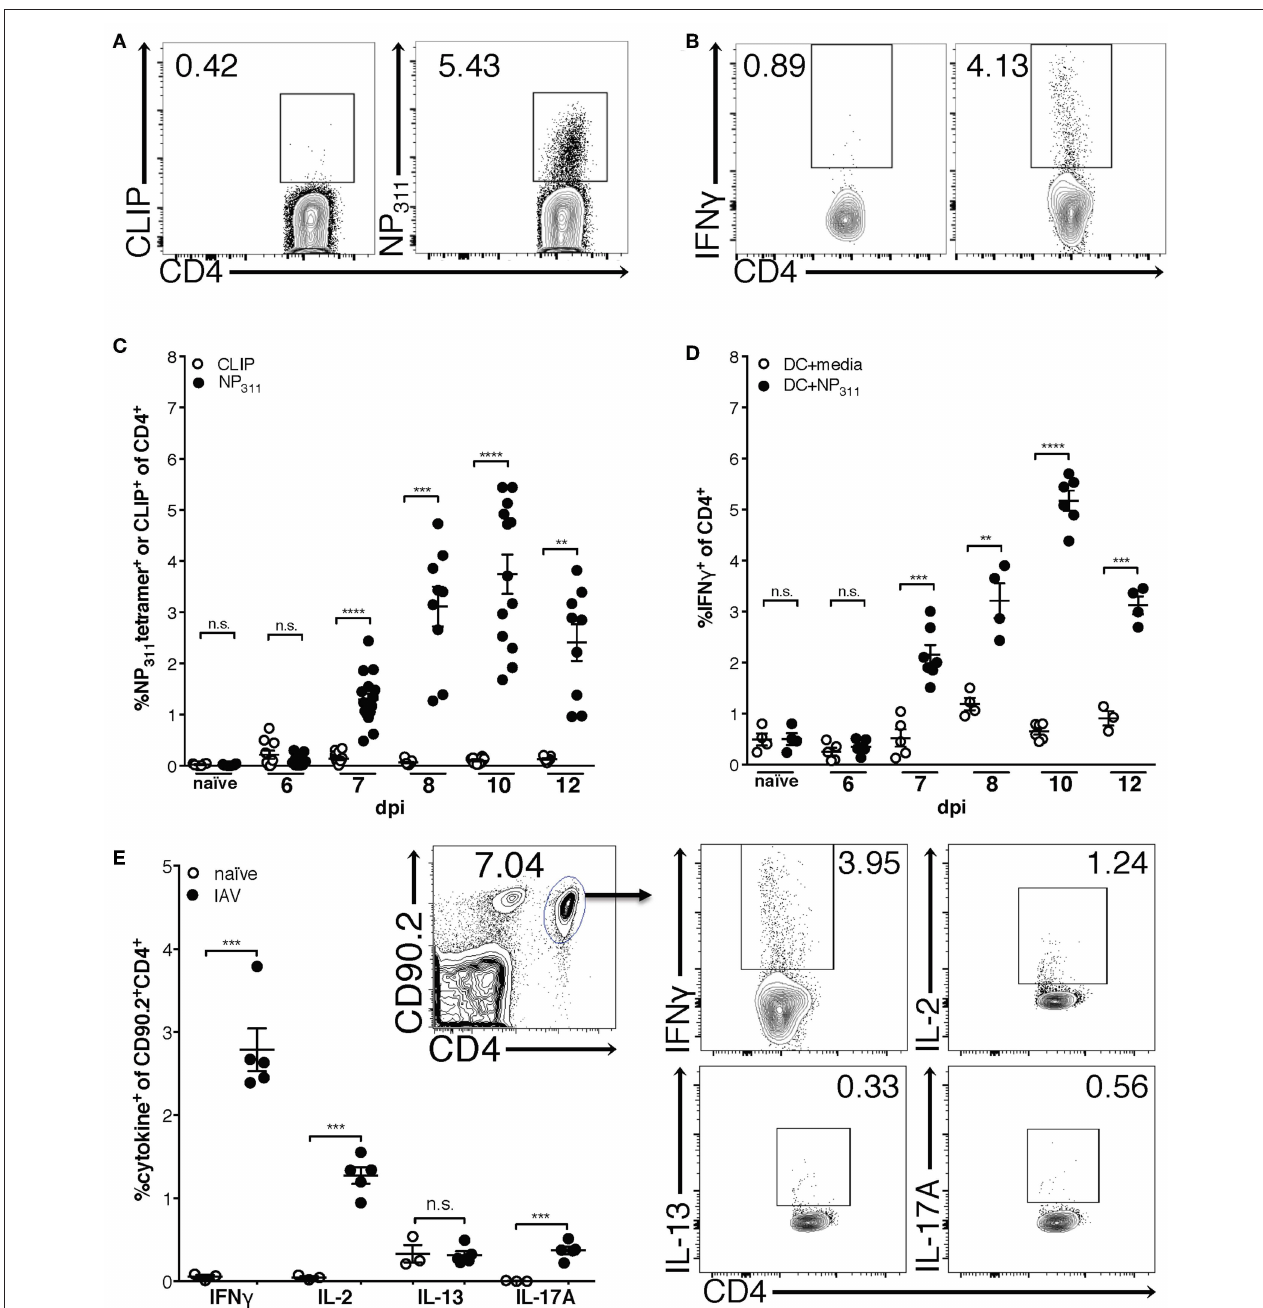
FIGURE 1 | The frequency of NP 311 -specific CD4T cells in the lungs peaks at 10 dpi. Mice were infected with a 0.05LD 50 inoculum of IAV-PR8 and lungs were harvested at the indicated times post-infection. The frequency of NP 311 -specific CD4T cells in the lung at each time point was determined by tetramer staining [representative flow plots (day 10 p.i., A ) and quantification (A,C) ] or intracellular staining for IFN γ following incubation with NP 311 -peptide pulsed splenic DC [representative flow plots (day 10 p.i., B ) and quantification (B,D) ]. CD4T cells from the lungs on day 7 after infection with 0.05LD 50 IAV-PR8 were analyzed for expression of IFN γ , IL-2, IL-13, IL-17A following incubation with NP 311 -peptide pulsed spleen DC (E) . Samples were analyzed by flow cytometry. Representative flow cytometry plots are from IAV infected mice. Each point represents one mouse and mean and SEM are shown. n = 3–15 mice per time point from 2 to 3 separate experiments. ** p < 0.01, *** p < 0.001; **** p < 0.0001. ( Figures 4A,B , Supplementary Data Sheet 1 ). These data are (10, 18). Consistent with those findings, the majority ( ∼ 50– also consistent with Figure 1 , in which the relative frequency of 70%) of CD49d + CD11a hi CD4 T cells are T-bet + in the lungs NP 311 -specific CD4 T cells producing IFN γ ( Figure 1E ) of both C57Bl/6 and BALB/c mice at all measured time points